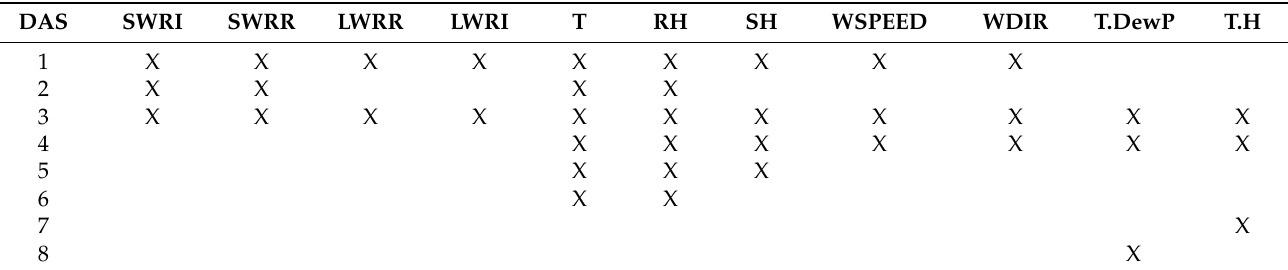
Table 3. Description of the data availability scenarios (DAS) and the corresponding variables used for each scenario. For all DAS, the target was the precipitation